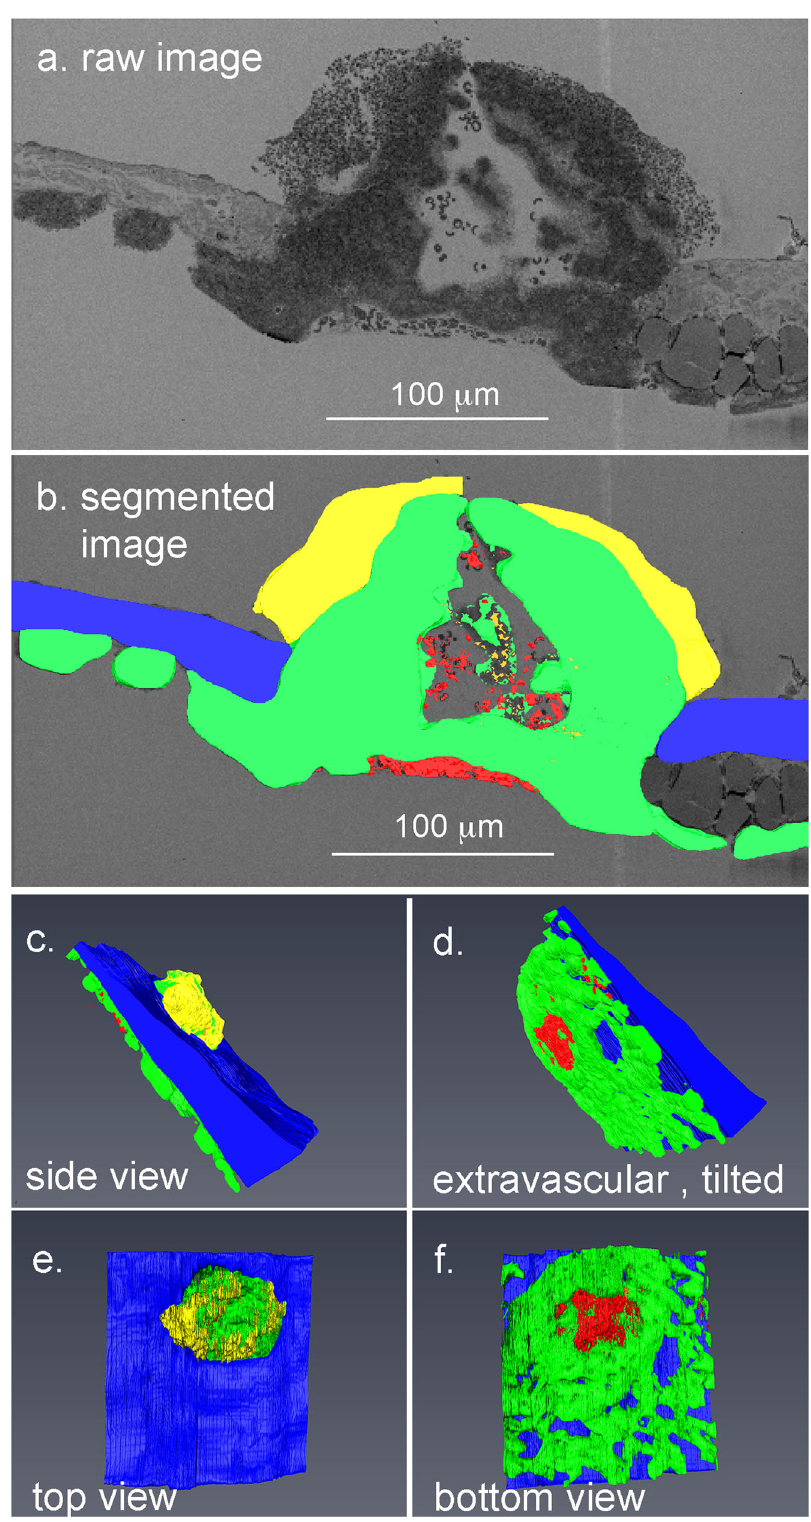
Fig. 3 Overall 3D structure reveals limited loosely adherent platelet sheathing of 5 min post-puncture wound thrombi. a / b Example of single segmented image slice from a 5 min post-puncture jugular vein thrombus showing loosely adherent platelets (yellow), tightly adherent platelets (green), vessel wall (blue), RBCs (red) trapped intravascularly with a vault, and a small RBC patch on the extravascular presumably entrapped by extravascular fi brin 14 . Flow from left to right. c – f Full 3D rendering showing various features of the thrombus when viewed from different angles. Loosely adherent platelet sheathing of the intravascular thrombus crown is limited to small patches. RBC (red), tightly adherent platelets (green), degranulated platelets (orange), loosely adherent platelets (yellow), vessel wall